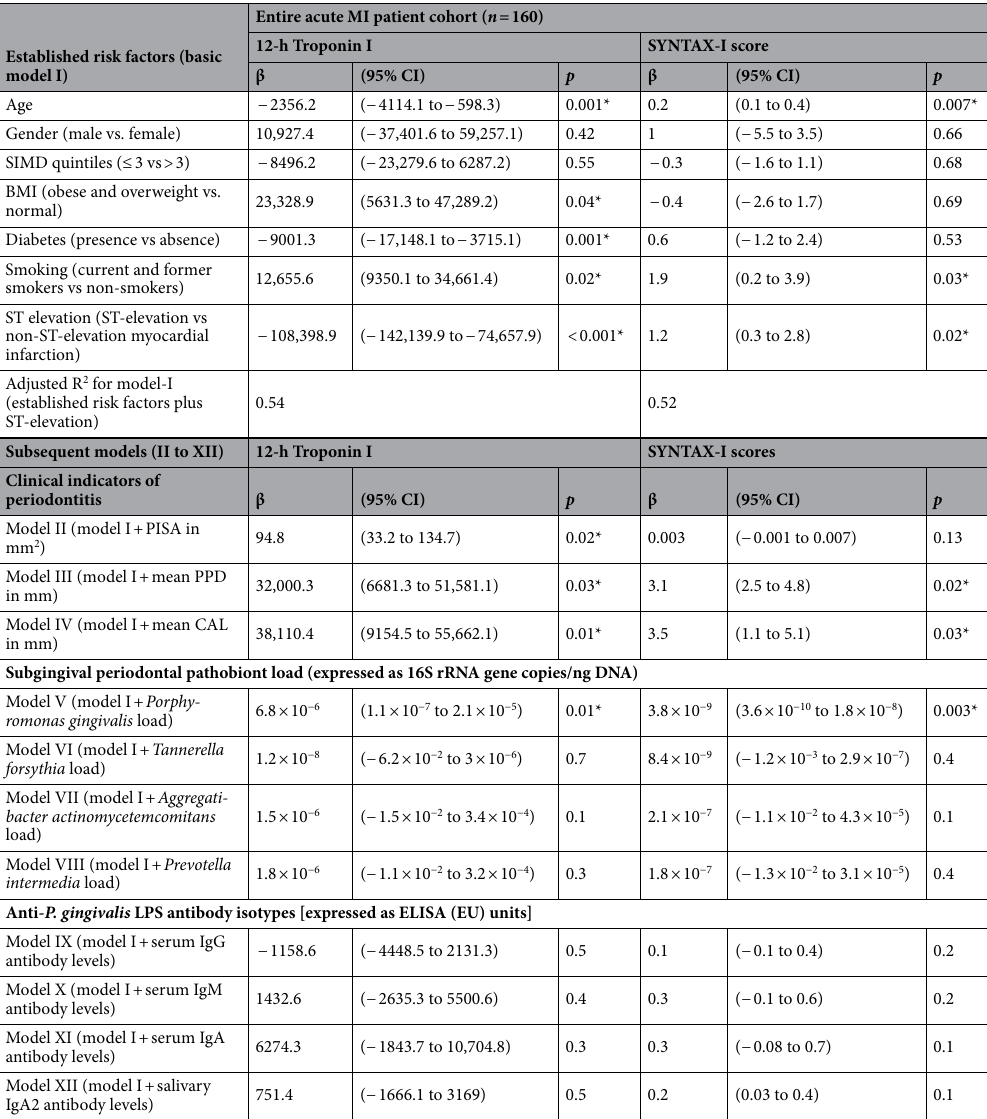
Table 3. Hierarchical linear regression of periodontitis-related indicators with 12-h Troponin I and SYNTAX-I scores as outcome variables ( n = 160). The established risk factors were introduced in model I followed by individual additions of clinical periodontal disease indicators: per mm 2 in periodontal inflamed surface area (PISA) (model II), per mm increase mean probing pocket depths (PPD) (model III), and mean clinical attachment loss (CAL) (Model IV), respectively; followed the subgingival increase of 16S rRNA gene copies/ng DNA microbial loads of P. gingivalis (Model V), T. forsythia (Model VI), A. actinomycetemcomitans (Model VII), P. intermedia (Model VIII) and then per EU unit increase of anti-P. gingivalis LPS antibody isotypes: serum IgG (Model IX), serum IgM (Model X), serum IgA (Model XI), and salivary IgA2 (Model XII). R 2 coefficient of determination, β unstandardised regression coefficient, CI confidence interval. * = statistically significant ( p < 0.05), BMI body mass index, SIMD Scottish Index of. Multiple Deprivation, SYNTAX The Synergy between percutaneous coronary intervention with TAXUS drug-eluting stent and Cardiac Surgery Score, ELISA The enzyme-linked immunosorbent assay, LPS lipopolysaccharide.